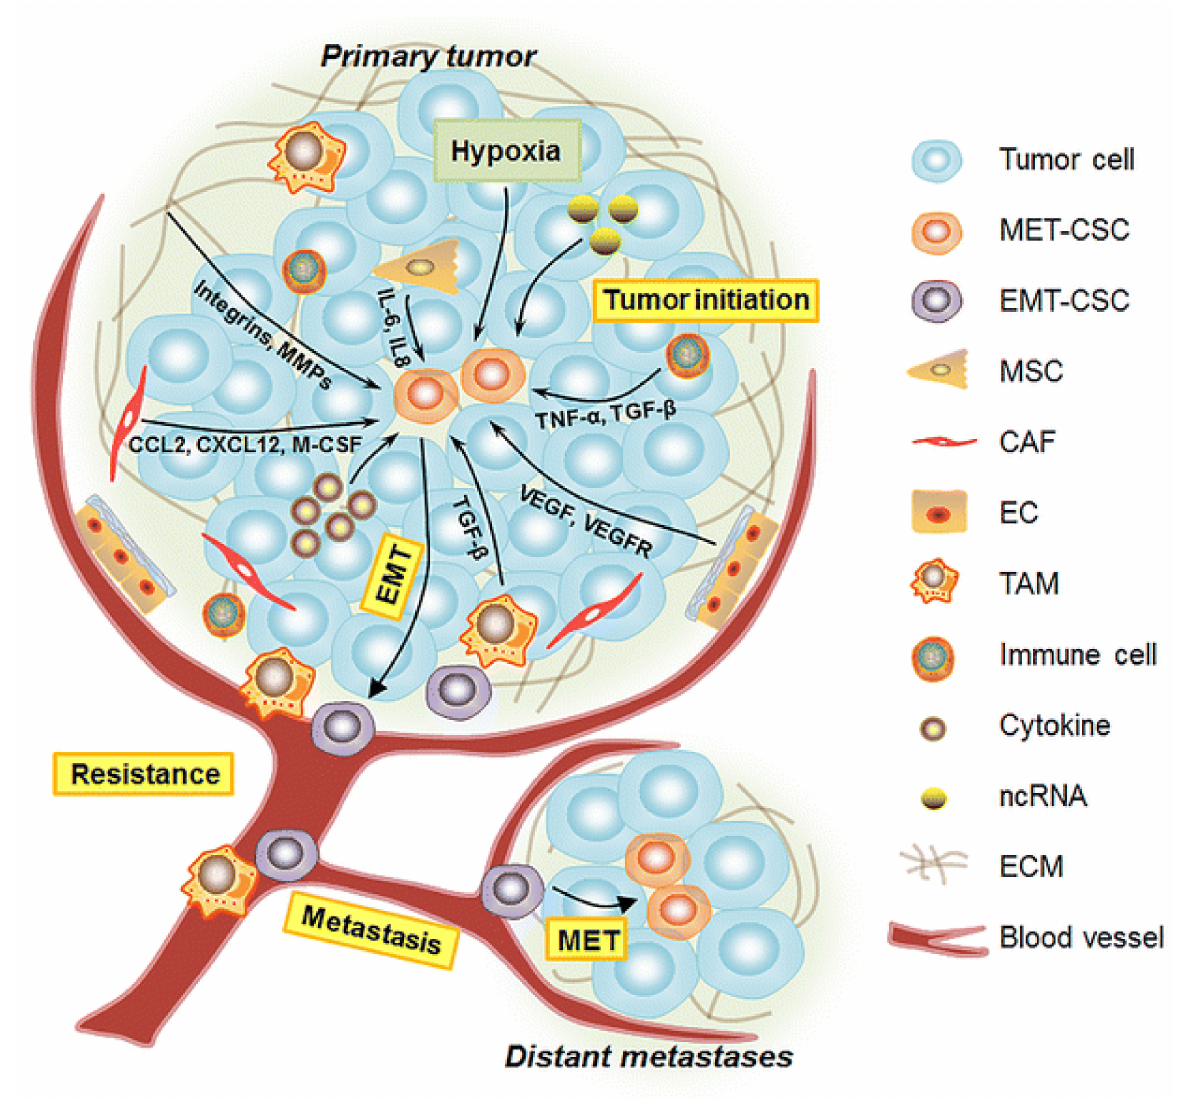
Figure 9. Breast cancer stem cell: the roles and therapeutic implications. Properties and regulation of BCSCs. This schematic diagram represents the interactions between CSCs and the surrounding tumor microenvironment, which have a direct effect on breast cancer cell malignancy and lead to tumor initiation, EMT, MET, metastasis, and therapeutic resistance